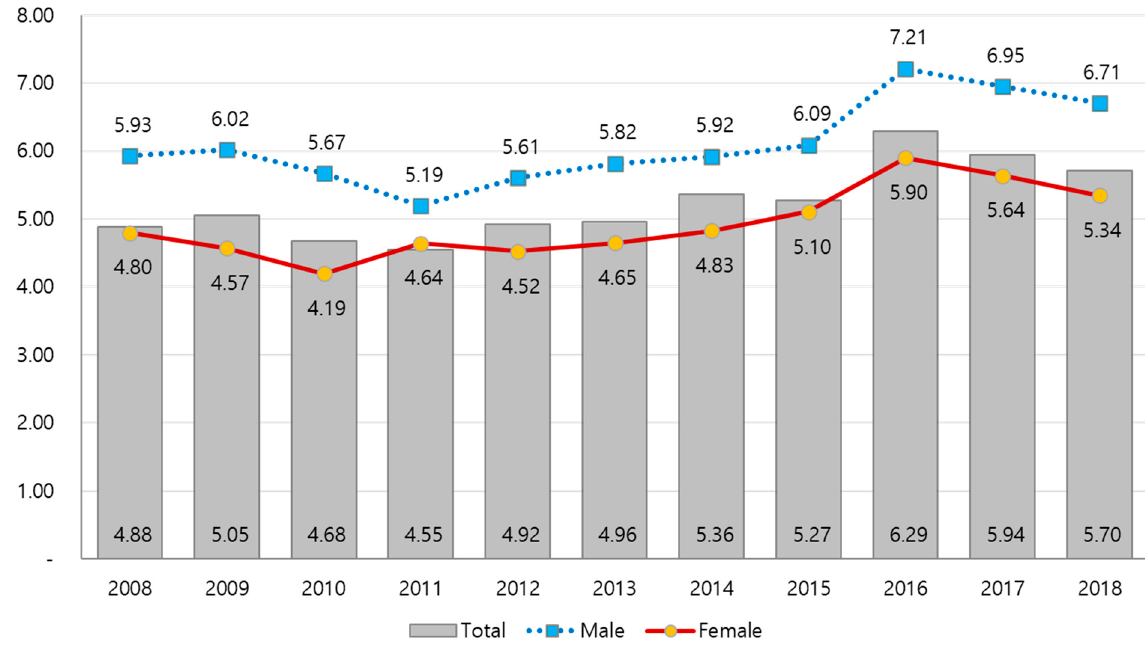
Figure 2. Difference (95th and 5th percentile) of HALE for males and females by region in Korea (unit: years).